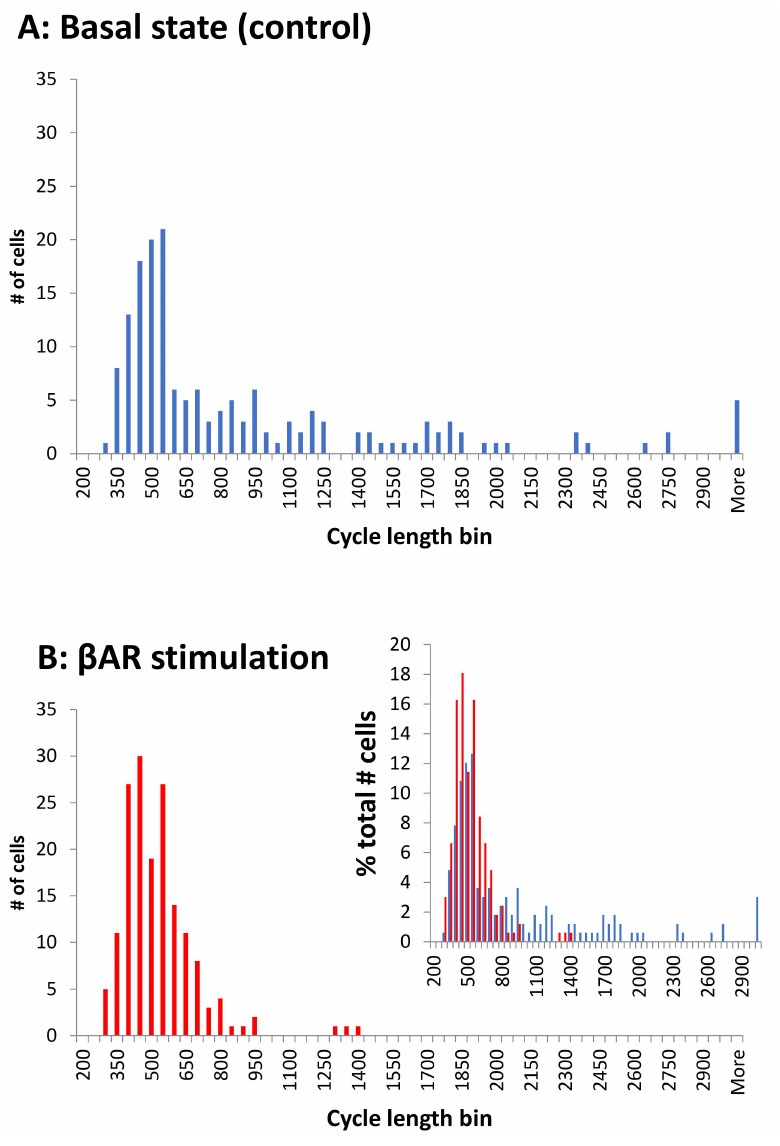
Figure 4. β AR stimulation synchronized cell rates around a higher (on average) common rate, i.e., a shorter cycle length. Histograms show the cycle length distributions in 166 cells tested in the present study. Bin size is 50 ms. ( A ): In the control. ( B ): In the presence of β AR stimulation. Inset: overlapping histograms in panels A and B expressed in terms of the percentage of cells in each cycle length bin illustrate a narrower, synchronized distribution of cycle lengths in stimulated cells (red) relative to control